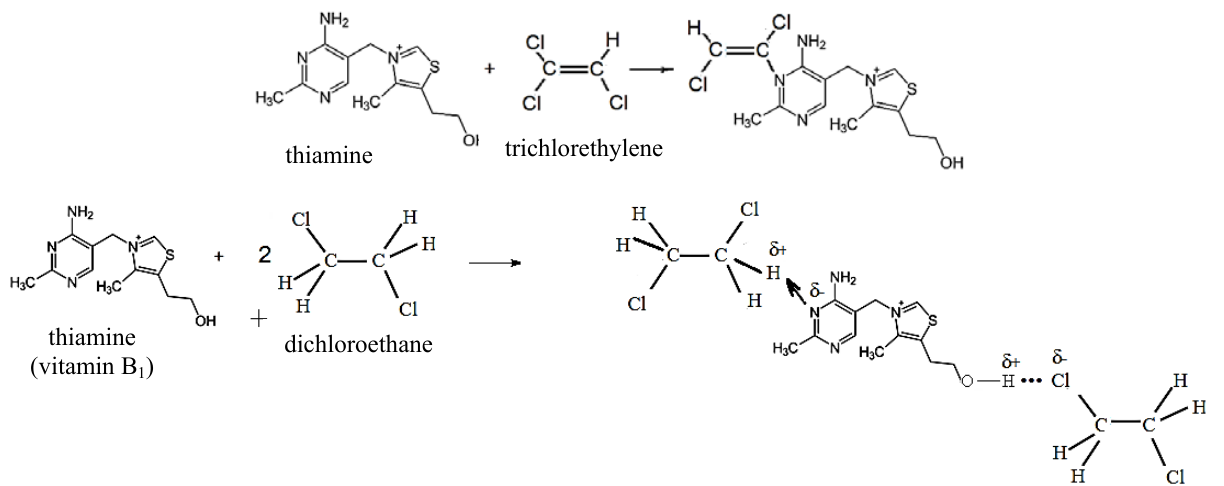
Fig. 14. Chemical interaction of vitamin B 1 with the priority contaminants contained in water.